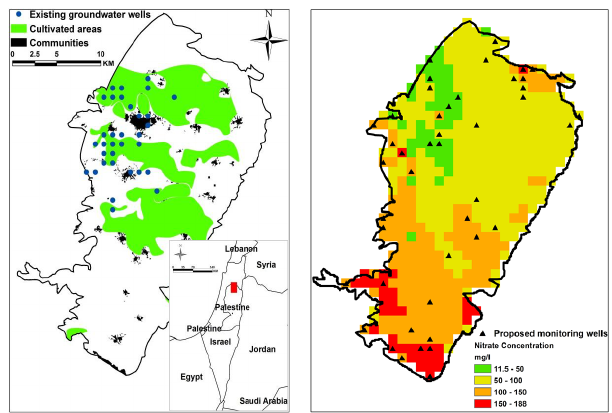
Fig. 2. Eocene Aquifer study area. (Left) Palestinian communi- Figure2 Figure2 ties, abstraction wells, and cultivated areas. (Right) Average nitrate concentrations predicted by Monte Carlo simulations and proposed monitoring well locations (Khader,